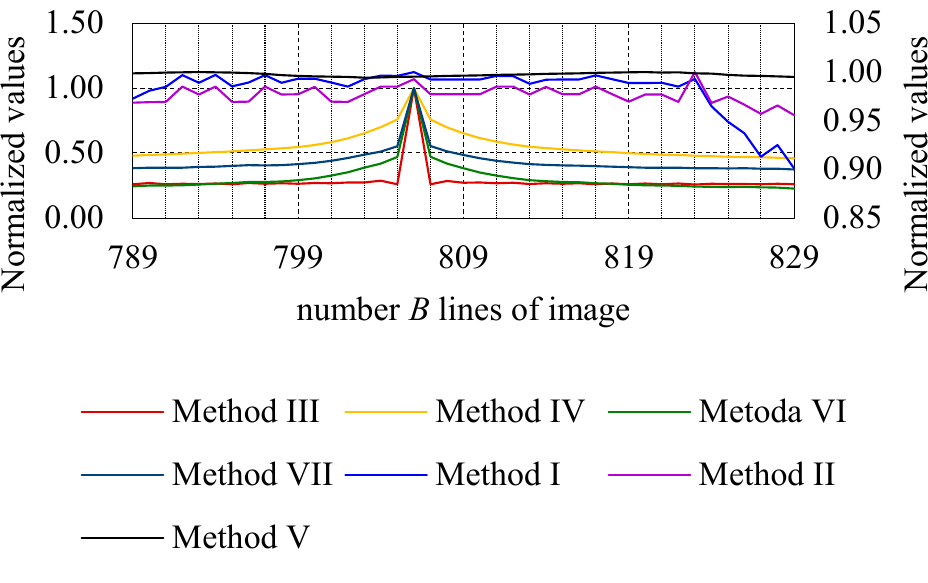
Figure 15. Normalized values (in relation to the maximum value) of the variability of measures as a function of the number of image lines, supporting the determination of the correct number of lines of the image reproduced for the source image in the form of a picture from Figure 7c—VGA graphic standard, computer monitor operating mode 1024 × 768/60 Hz, frequency of the reveal emission signal f o = 558 MHz, reception bandwidth BW = 10 MHz, correct number of lines B Corr =